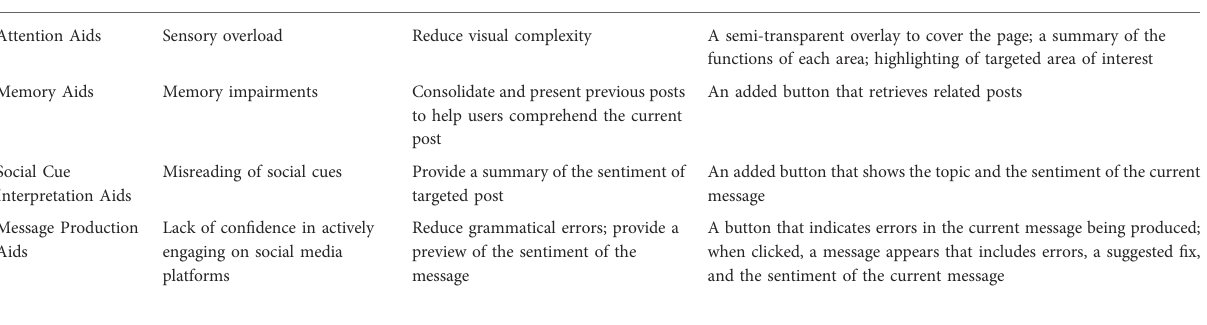
TABLE 1 Summary of four aids and their design